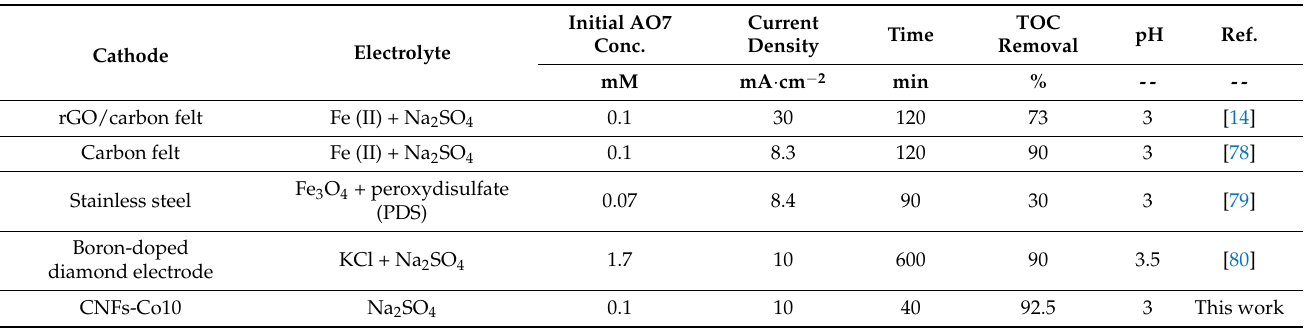
Table 2. Comparison of the efficiency of the self-supported CNF-Co10 electrodes and of some cathodes described in the literature for AO7 mineralization. Initial AO7 Cathode Electrolyte